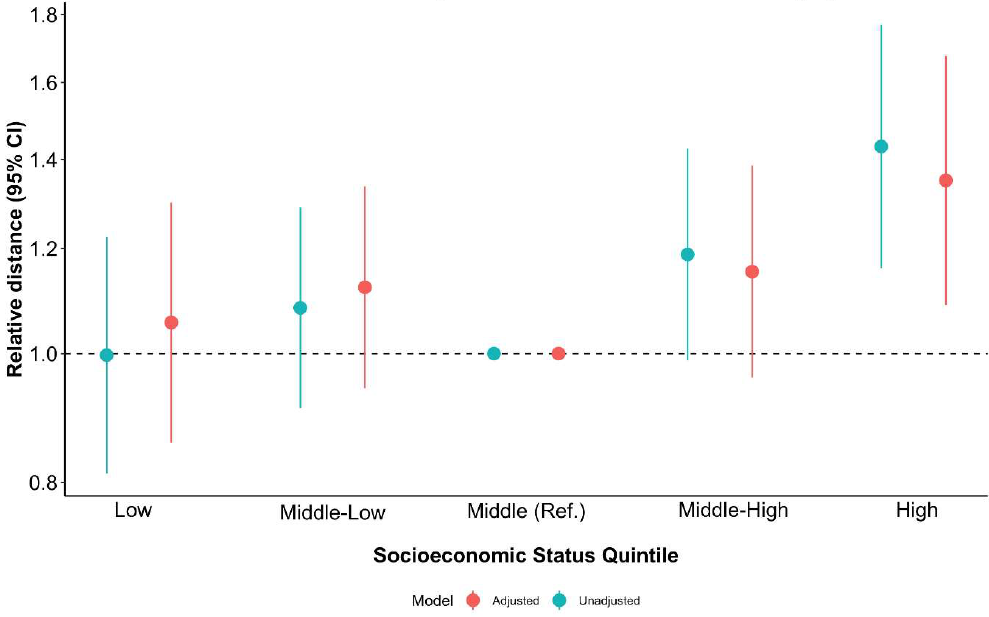
Figure 3. Multilevel linear regression modeling neighborhood-level socioeconomic status with distance to unhealthy retailers (in the log scale) from schools across Madrid (2017) before and after adjusting for population density.